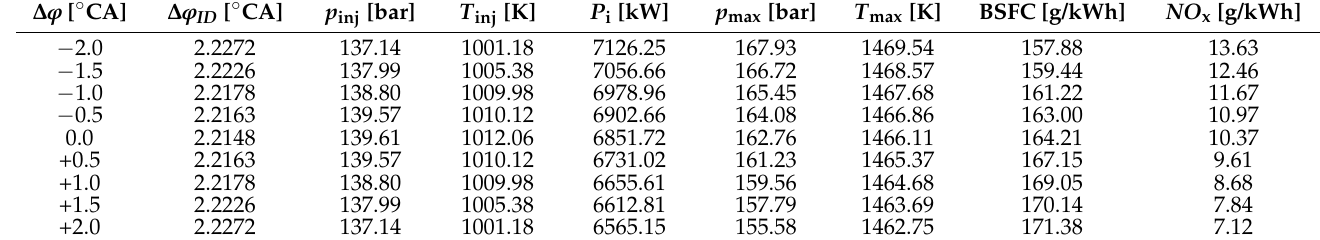
Table 10. Parameters and NO x emission changes due to changes in fuel injection timing at 75% MCR [22].